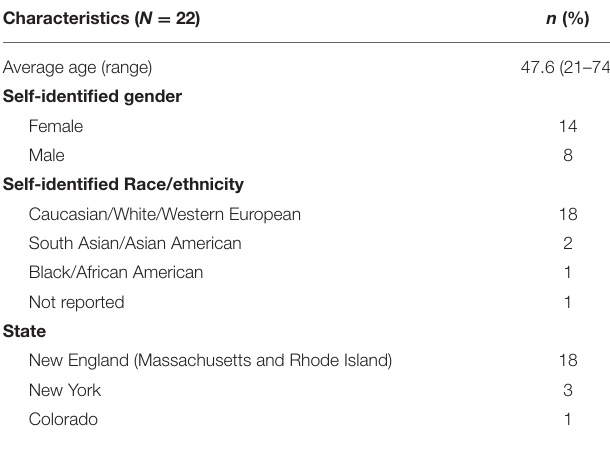
TABLE 1 | Participant demographic